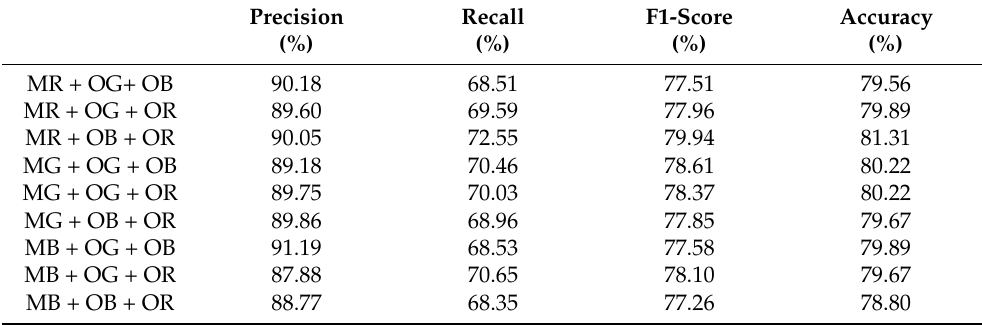
Table 1. Deep learning model performance evaluation score of each RGB channel superposition case.